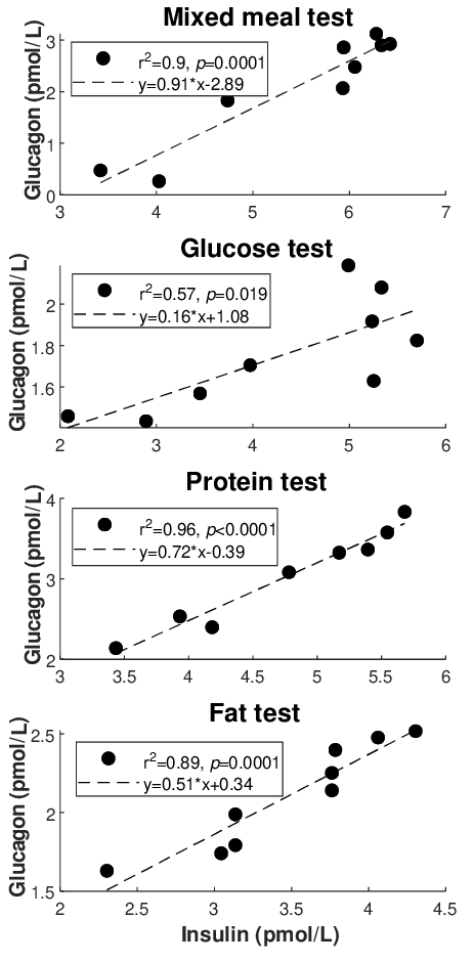
Figure 3. Best regression (highest R 2 value) between glucagon and insulin for each metabolic test in individual regression analysis (direct regressions). All values are log-transformed.